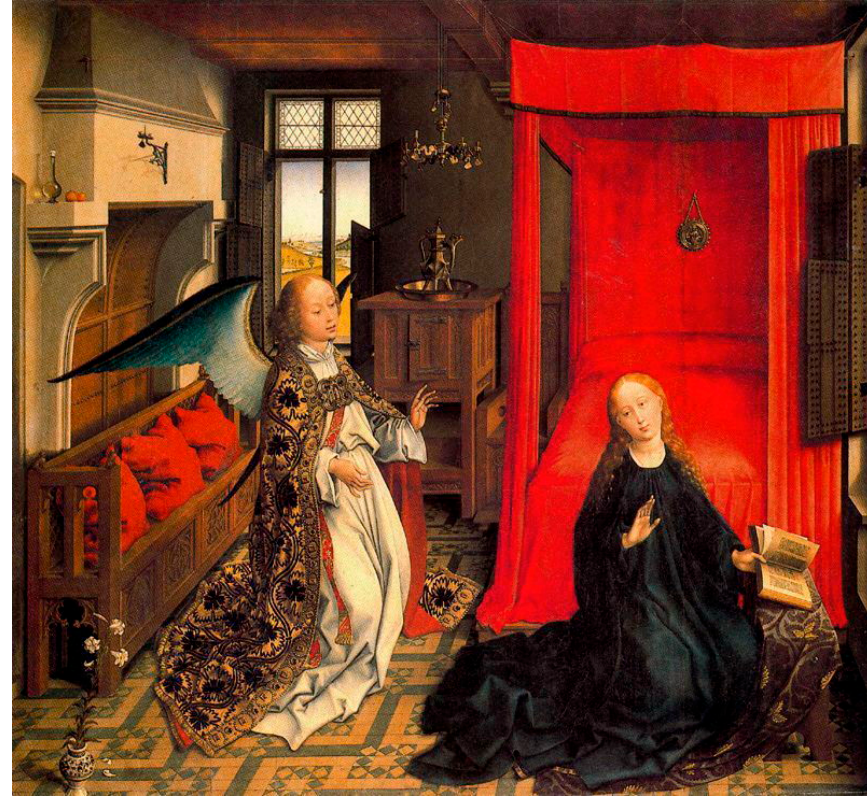
Figure 5. Rogier van der Weyden, The Annunciation , c. 1434–1435, central panel of the Triptyc of the Annunciation , Musée du Louvre, Paris.